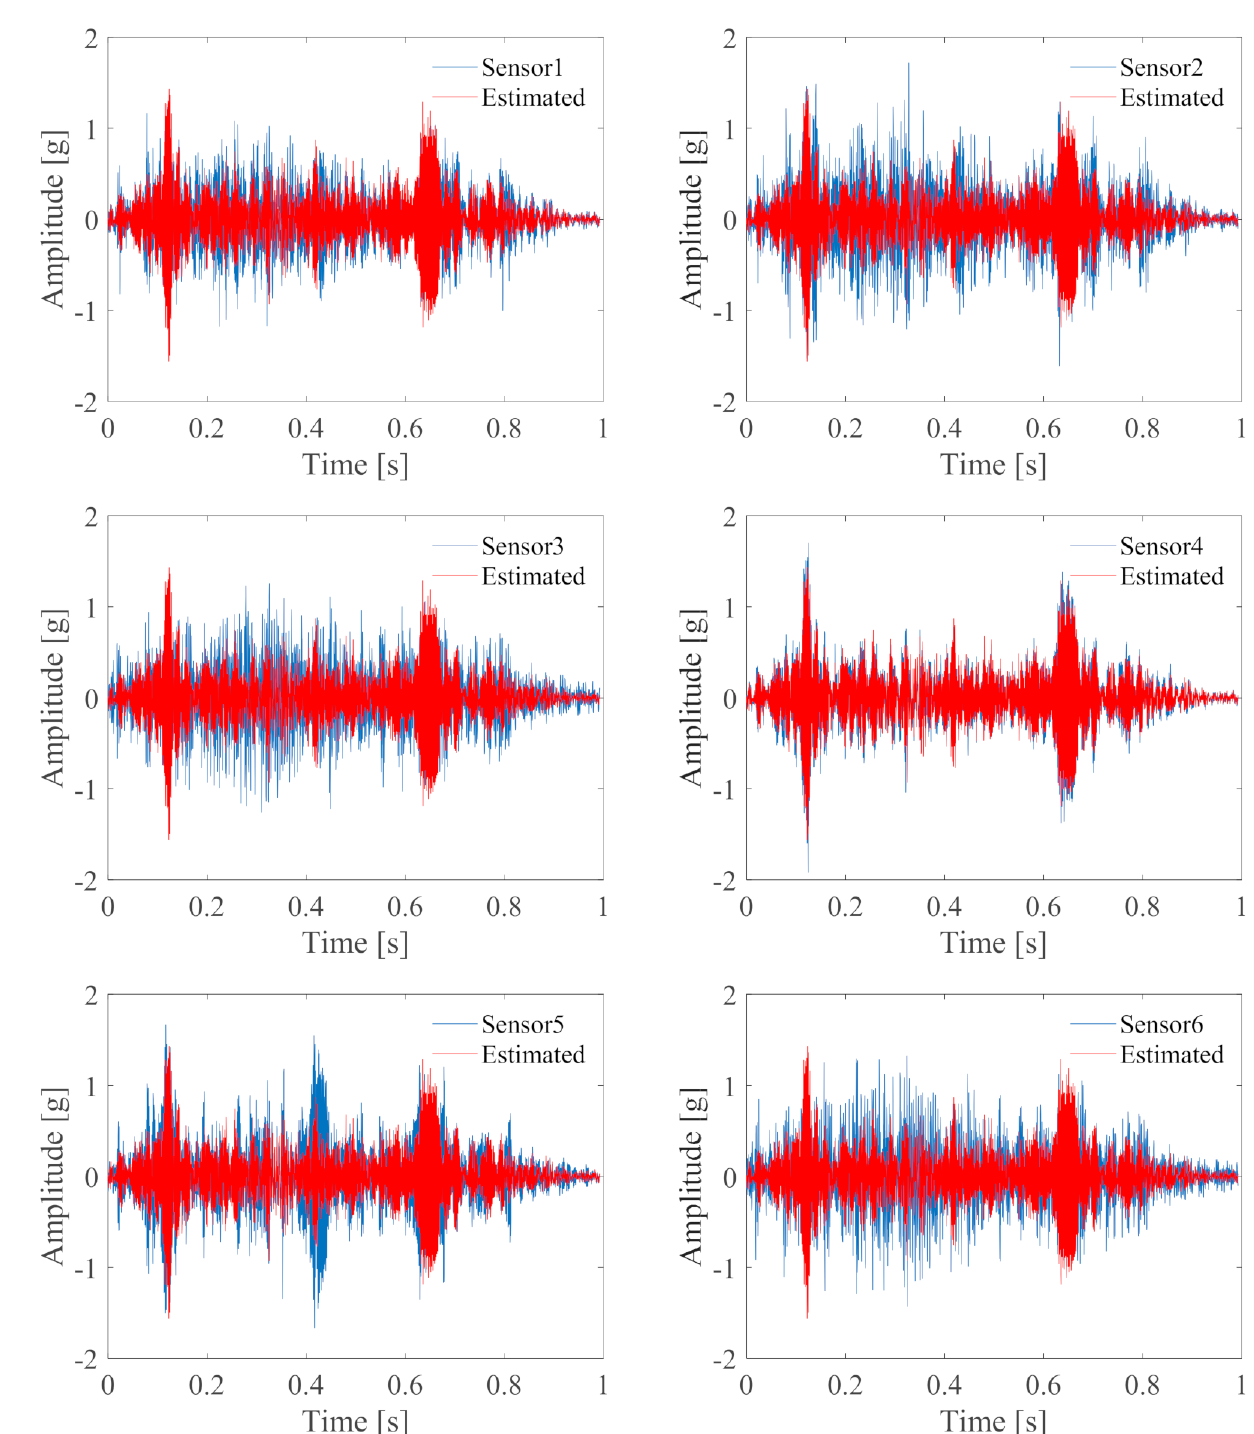
Figure 9. Contrasted results between estimated and collected signals in outer race fault